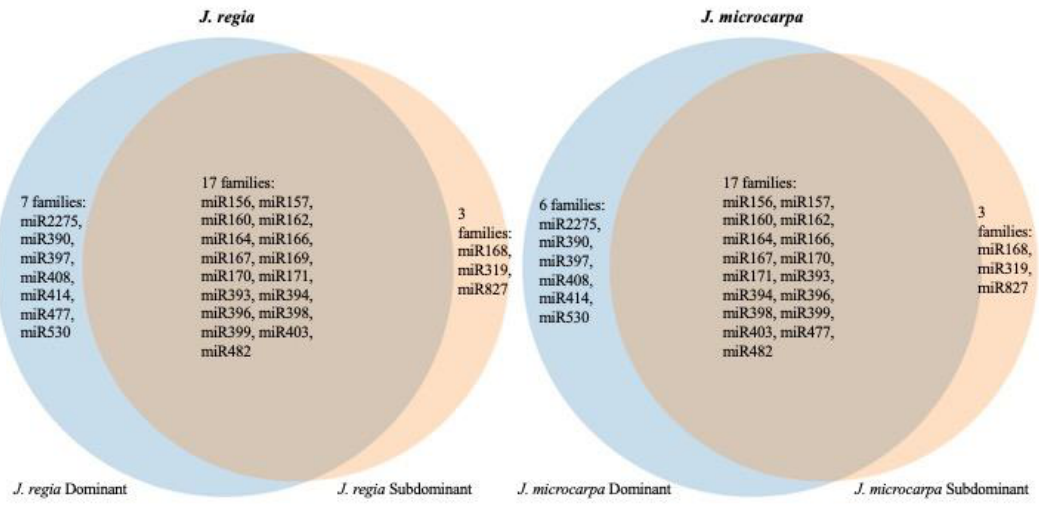
Figure 3. Venn diagrams of the shared and genome-specific miRNA families on dominant (blue) and subdominant (cream) chromosomes in the J. regia genome (left) and J. microcarpa genome (right).